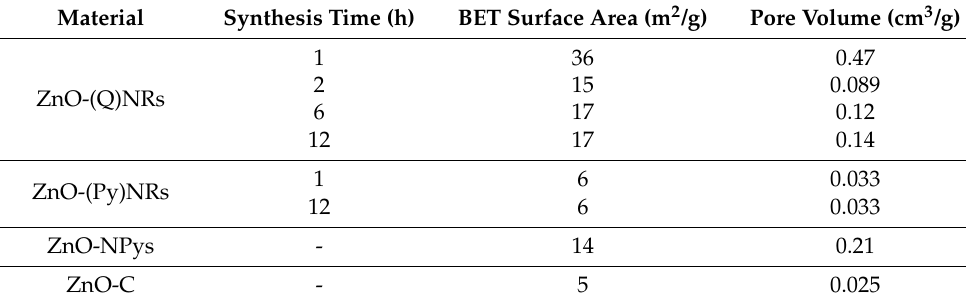
Table 2. Effect of synthesis time on BET surface